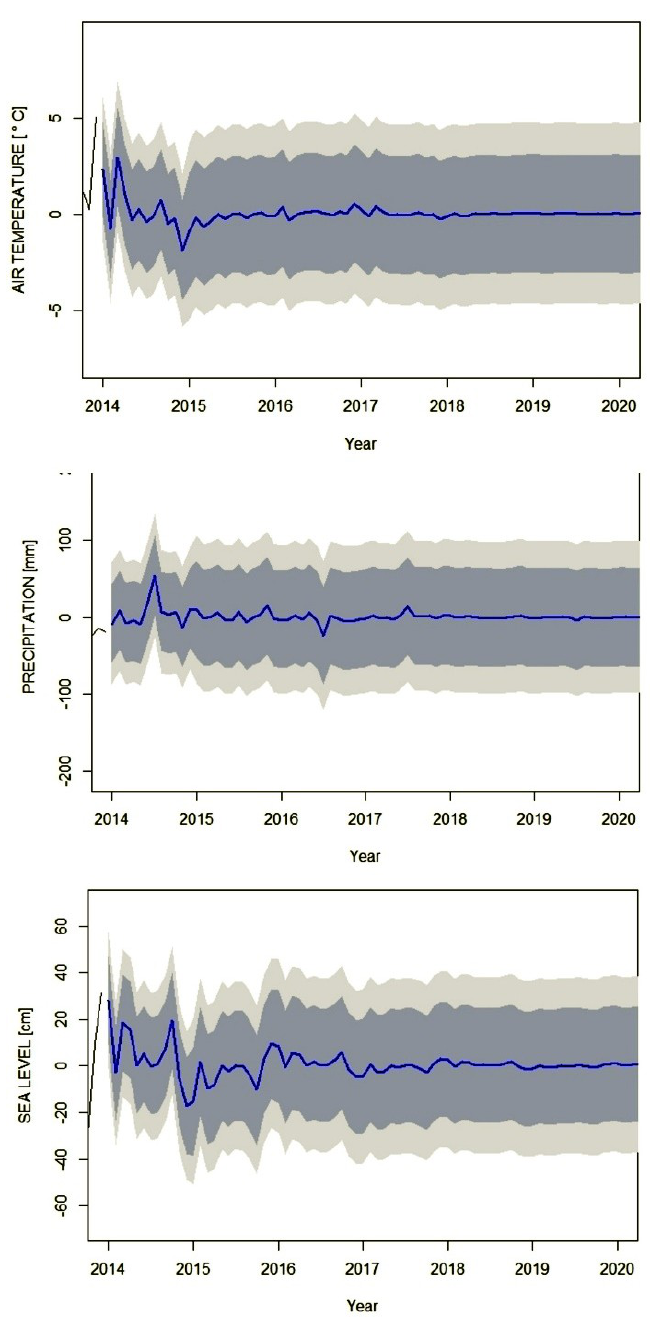
Figure 7. Short-term ARIMA model forecasts (2016–2020) for average monthly air temperature, total monthly atmospheric precipitation, and average monthly sea level in Ustka.